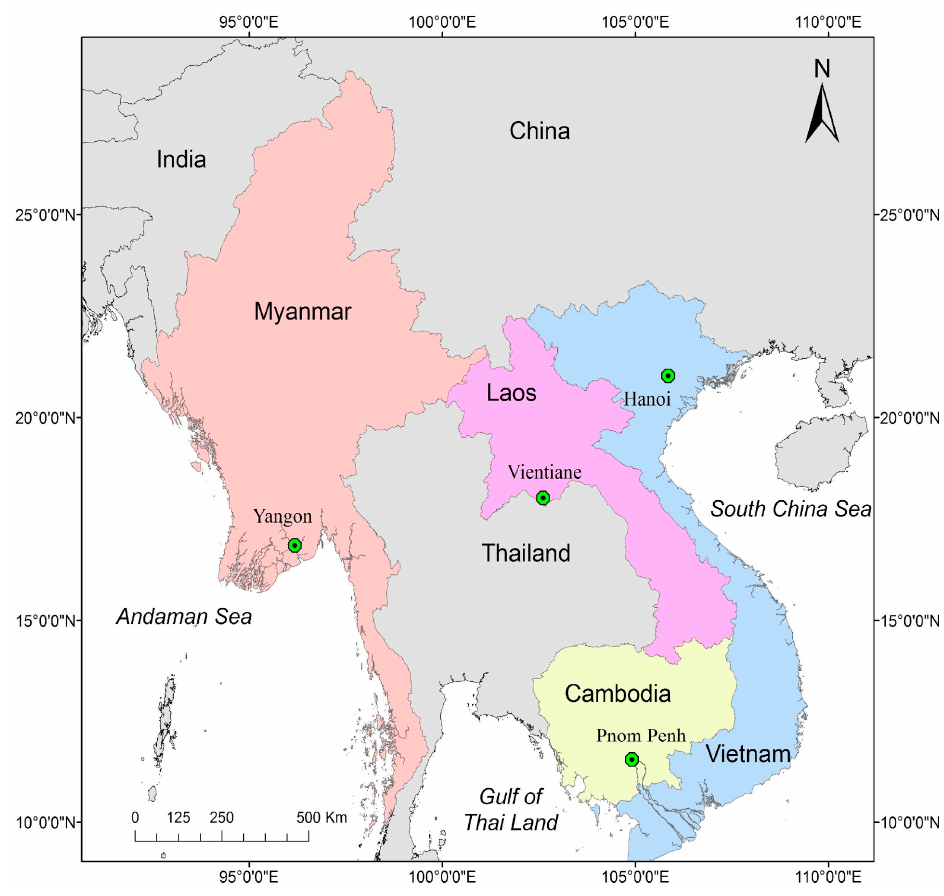
Figure 2. Study area in Southeast Asia and locations of the four selected cities for accuracy assessment, which are represented by green-black symbols.